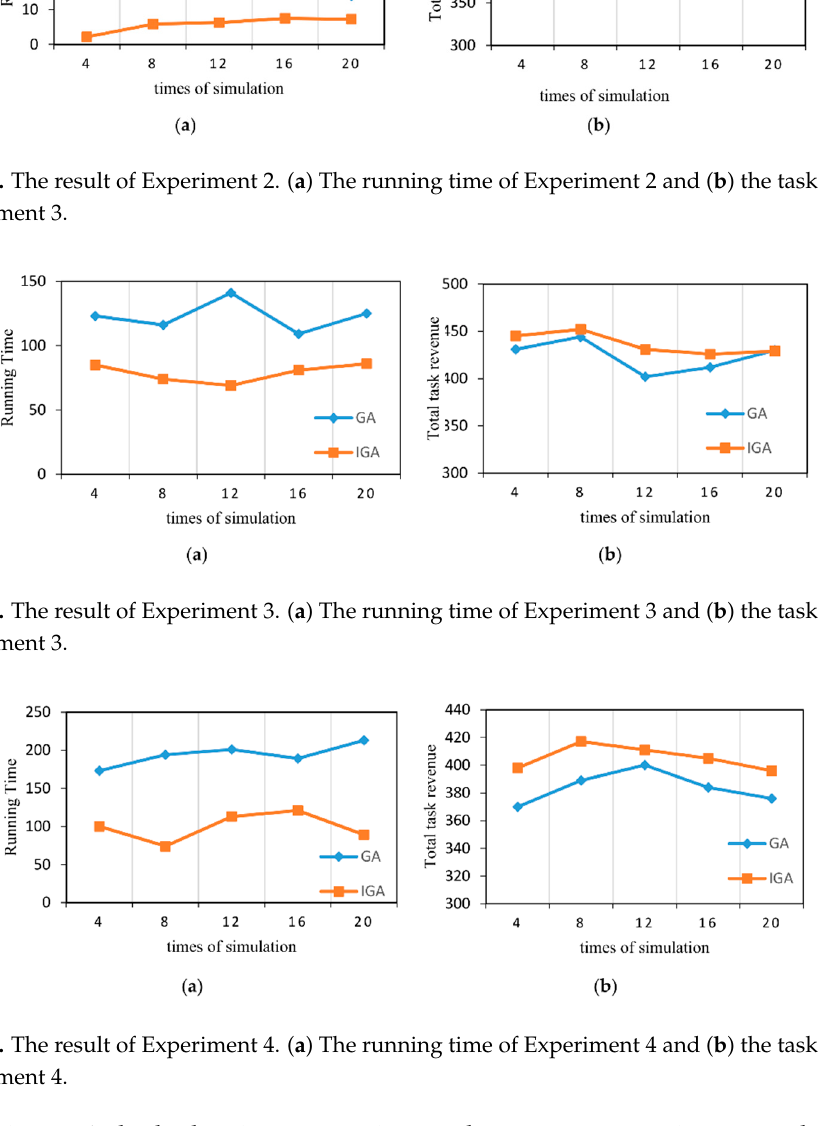
Figure 11. The result of Experiment 2. ( a ) The running time of Experiment 2 and ( b ) the task revenue of Experiment 3.